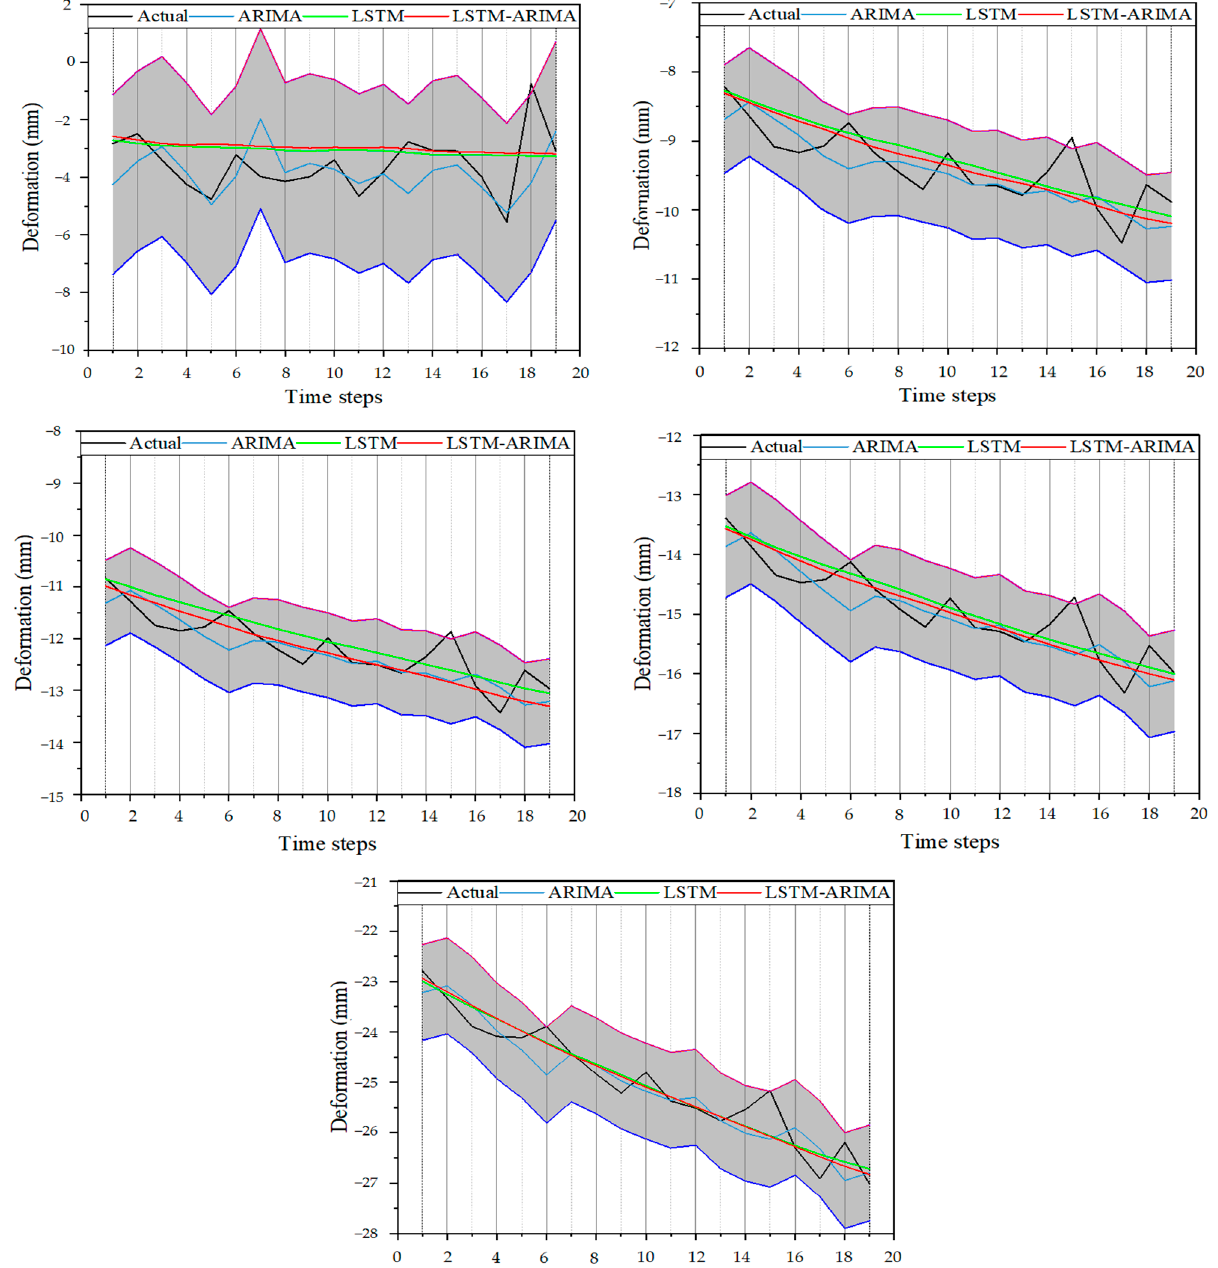
Figure 15. The performance comparison of ARIMA, LSTM, and LSTM − ARIMA models.